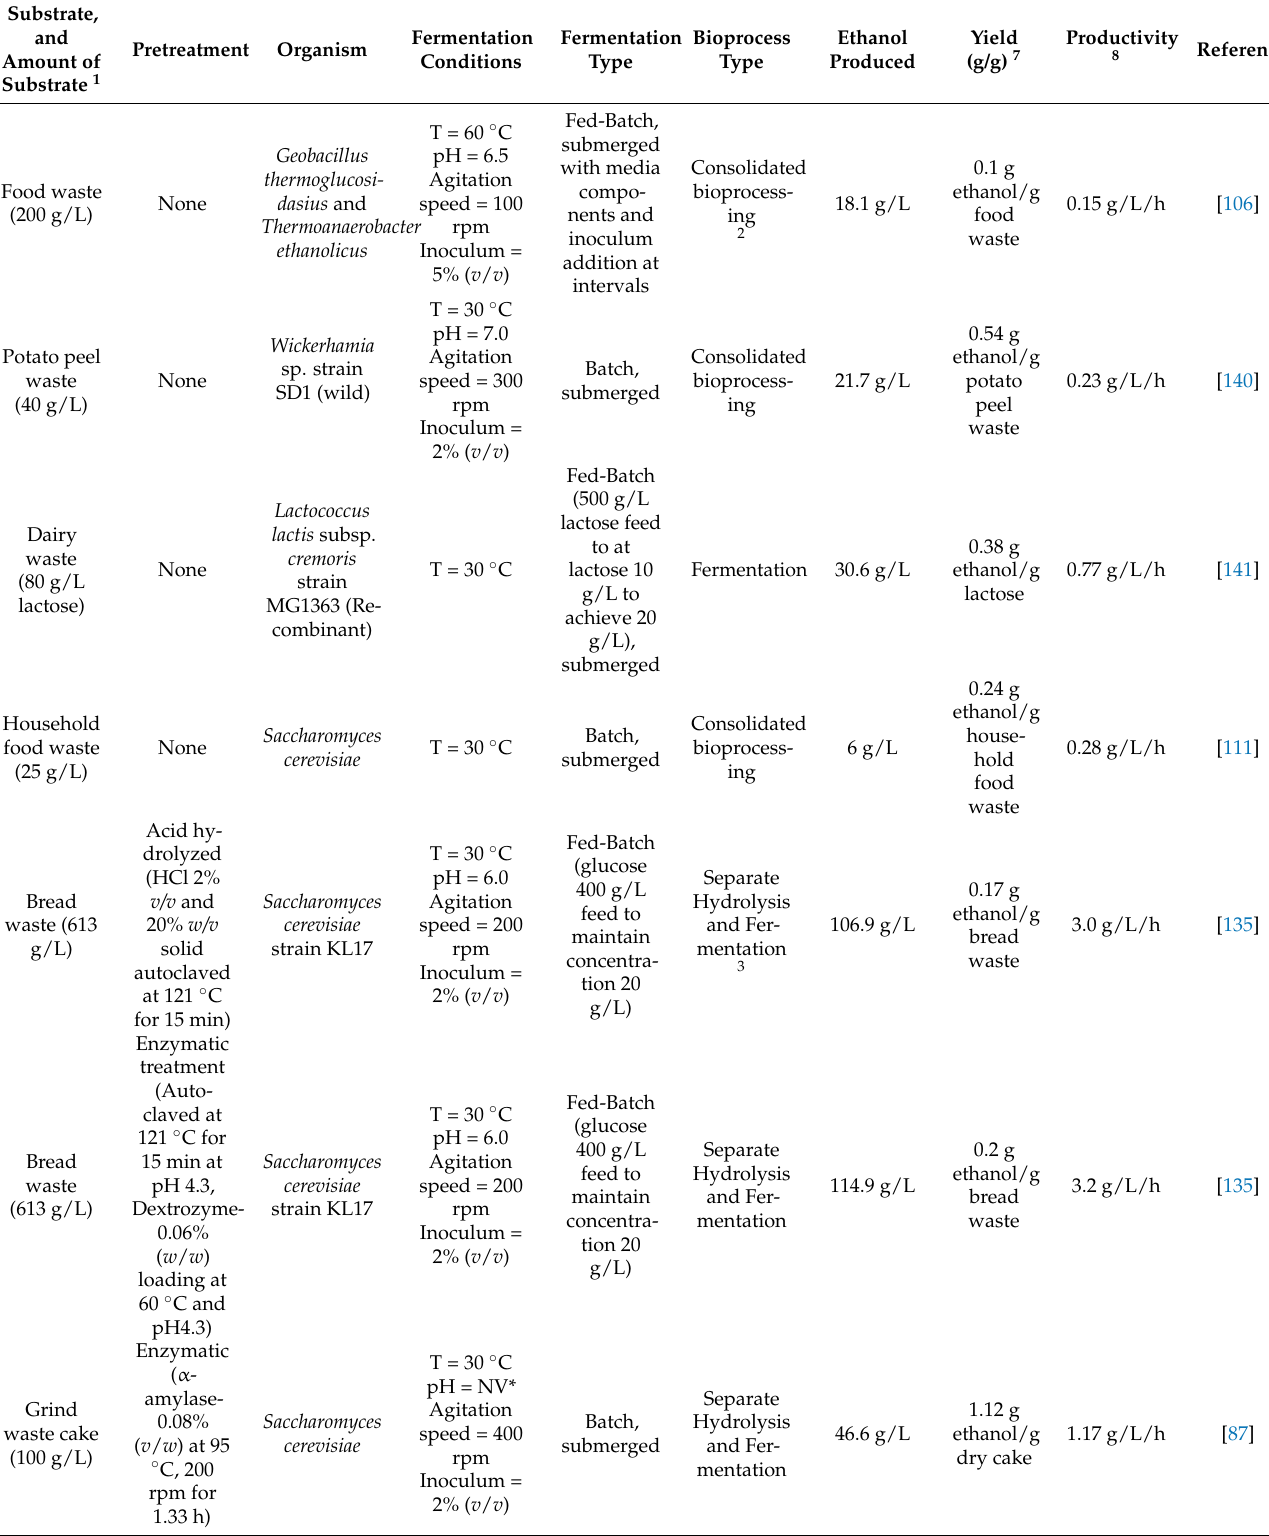
Table 2. The bioethanol production with different food waste including different parameters used during ethanol production in each